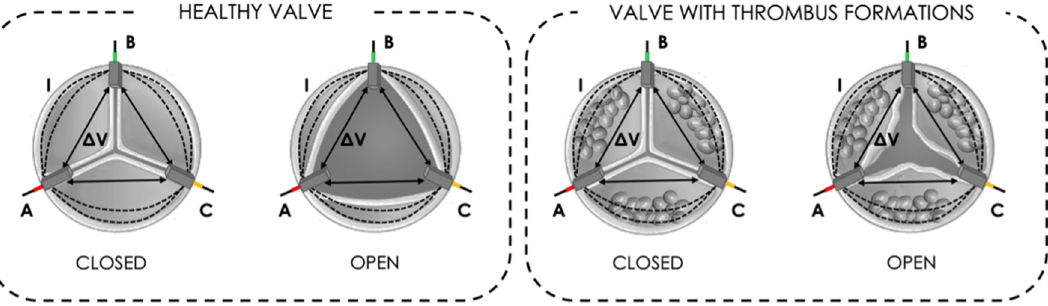
Figure 1. The principle of measurement of IntraValvular Impedance (IVI) for a healthy valve ( left ) and for a valve with thrombus formation ( right ): current pulses (I) are injected between each electrode pair to generate local electric field interference with leaflet movement, and potential difference ( ∆ V) is recorded.